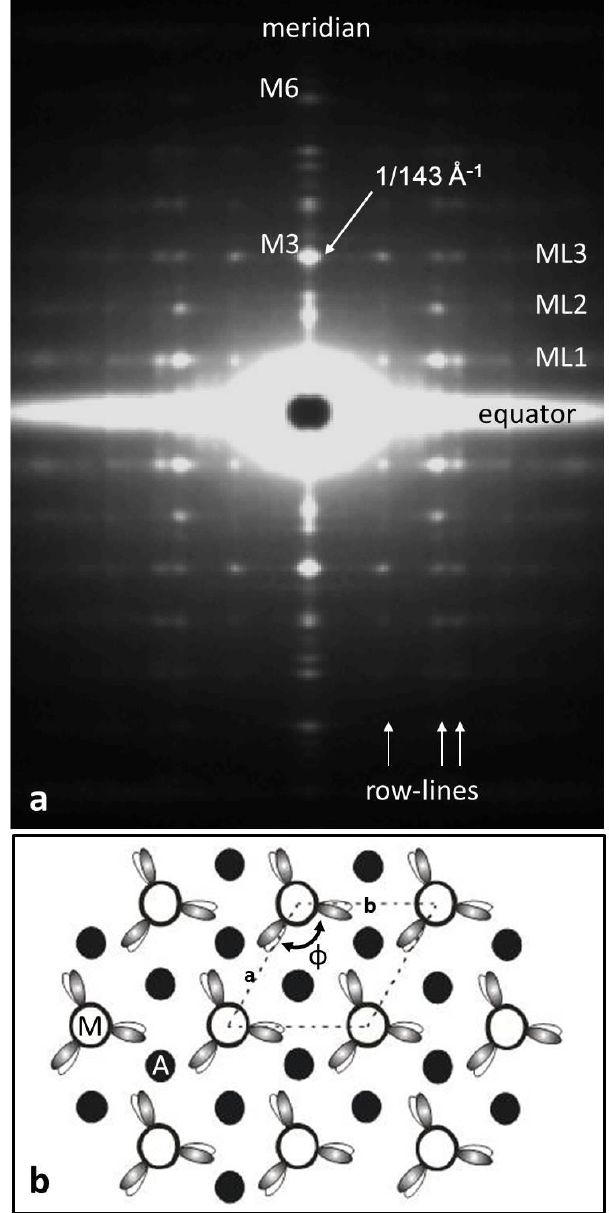
Figure 2. ( a ) The low-angle X-ray diffraction pattern from bony fish muscle (fibre axis vertical) showing the horizontal layer-lines and vertical row-lines on which the observed peaks are situated. Almost all of what can be seen here comes from the myosin filaments in the muscle. ( b ) The “simple lattice” unit cell of the A-band lattice in bony fish muscle viewed down the fibre axis showing the single rotation (N) of the myosin filaments around their long axes and the 3-fold rotational symmetry of the head arrangement on one crown of heads. Actin filament positions (black circles) at the trigonal points are labelled A.